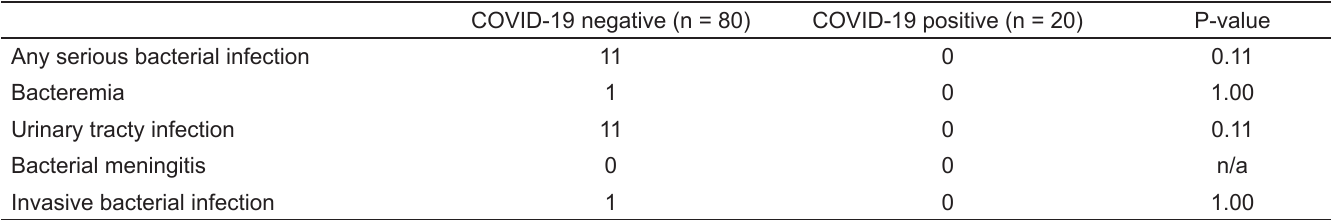
Table 3. Results from subgroup analysis of 29-60 days old.